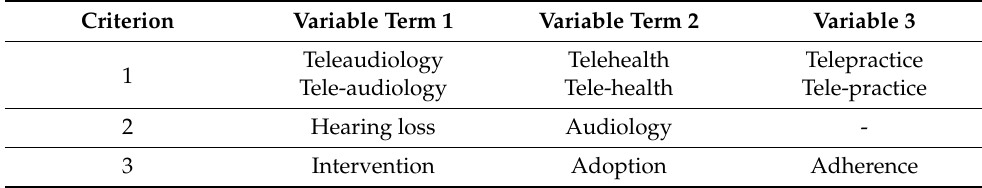
Table 1. Search terms as criterion applied as variable terms to identify studies pertaining to the use of teleaudiology in audiological intervention practices. Criterion Variable Term 1 Variable Term 2